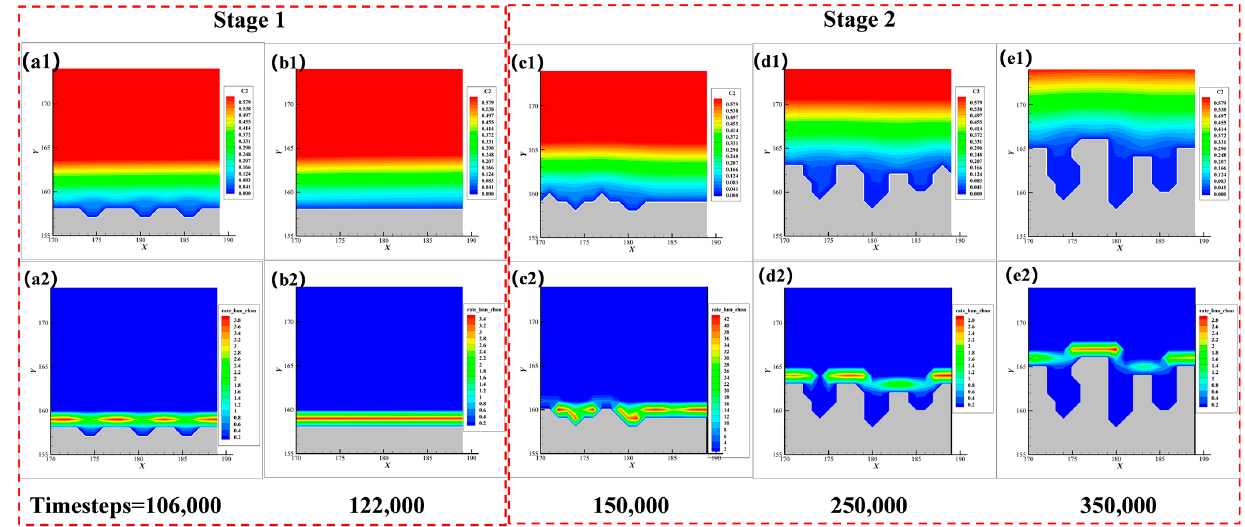
Figure 10. Change of local roughness with time: ( a1 )–( e1 ) Concentration distribution of reactants for the corresponding time step; ( a2 )–( e2 ) Precursor consumption rate corresponding to time step.